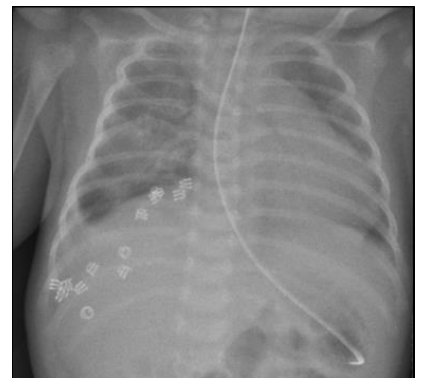
Figure 2: Chest X-ray. Post-operative spiral tack